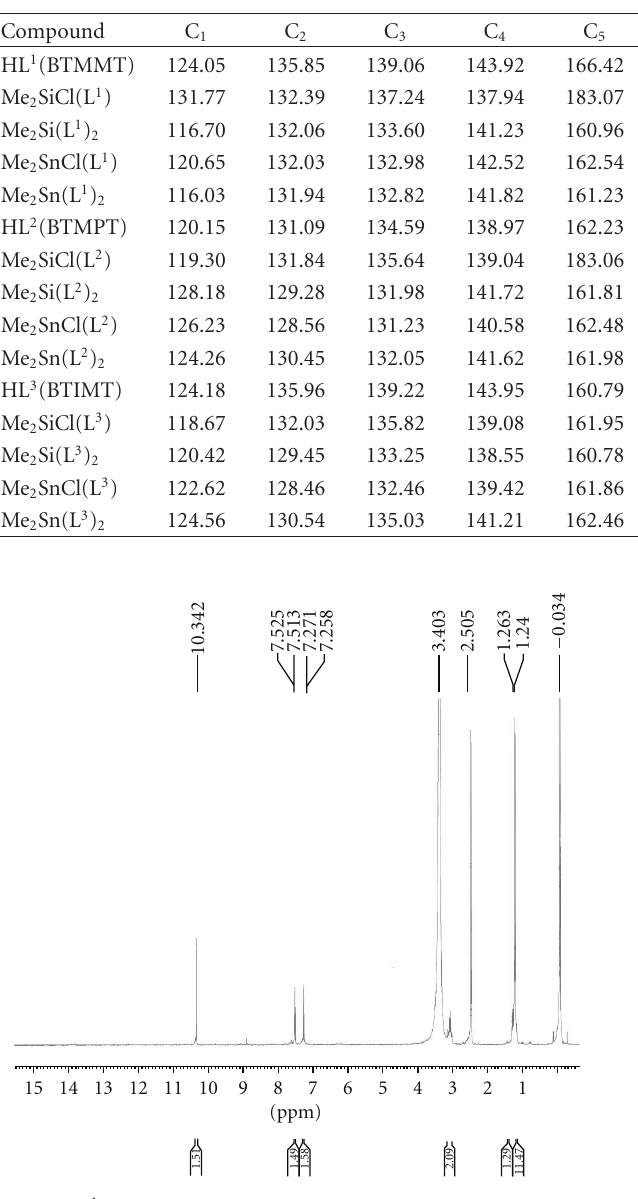
Figure 3: 1 H NMR spectrum of Si (1:1) metal complex of ligand (HL 3 ).